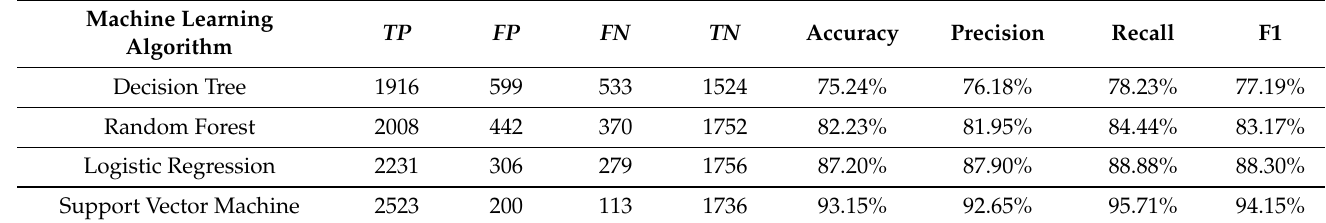
Table 2. Comparison of classifier